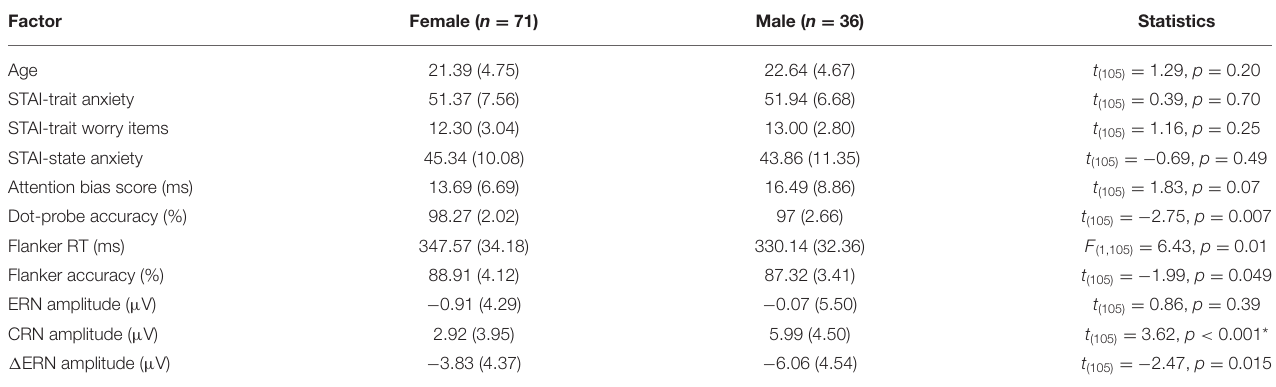
TABLE 1 | Mean differences (SDs) between females and males on study variables.